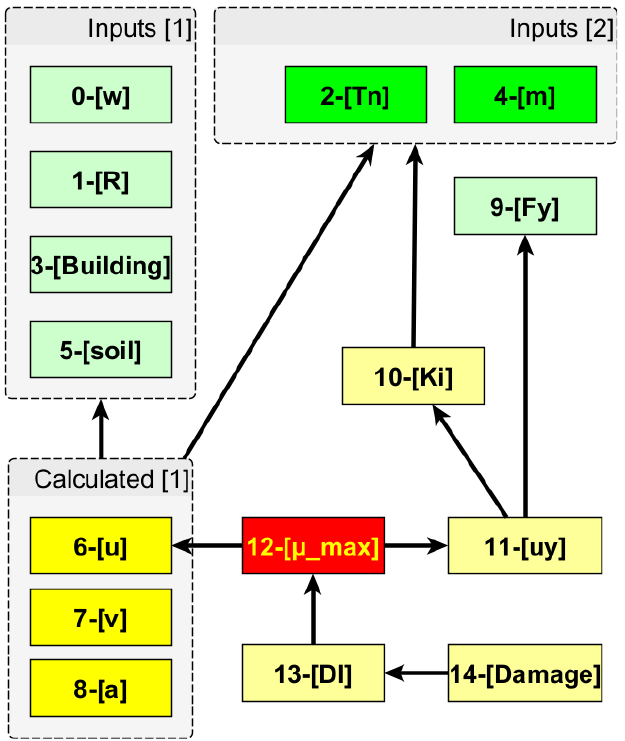
Figure 5. Dependency graph of the feature parameters in our implementation. An arrow from a parameter’s label to another indicates that calculating the latter directly depends on the former in our equations.